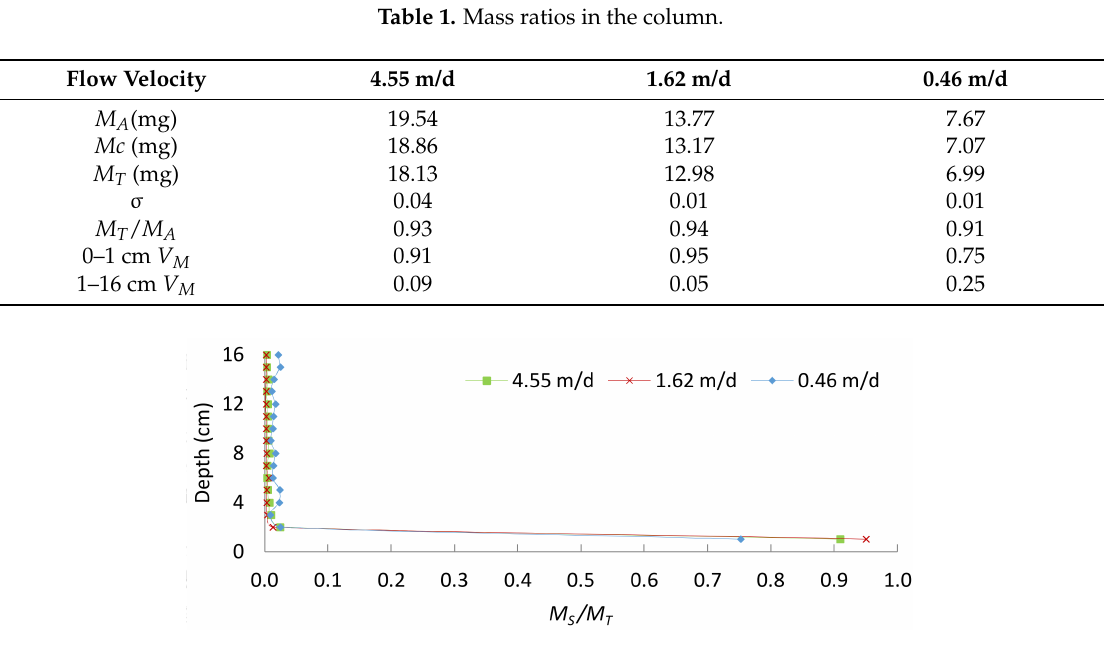
Figure 6. Deposition distribution along the